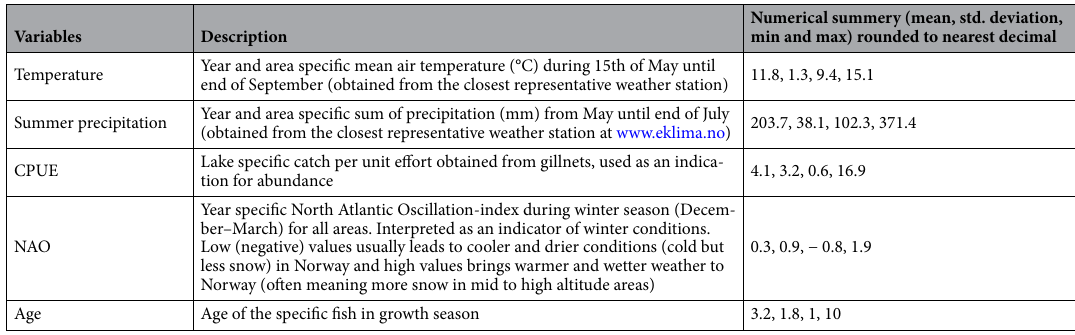
Table 2. Description of candidate variables used in the model selection process determining the most supported model for individual growth of brown trout.